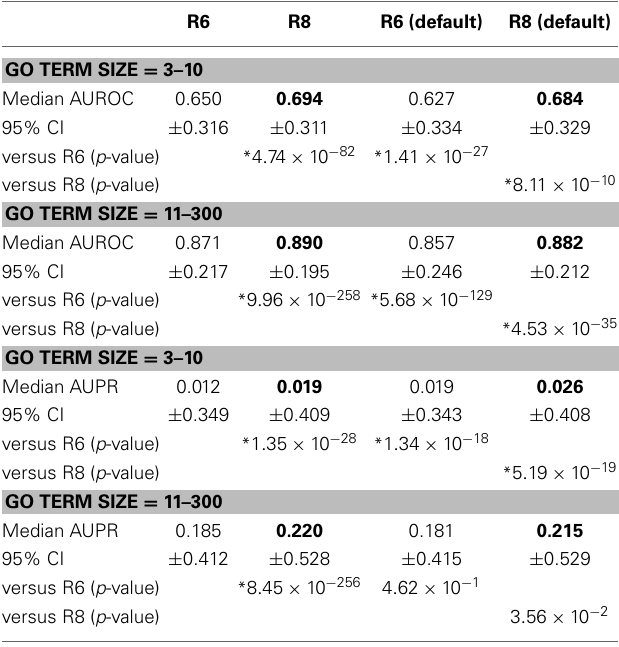
The Wilcoxon rank sum test was performed on the following pairs conditions: R6 versus R8, R6 versus R6 (default), and R8 versus R8 (default). The